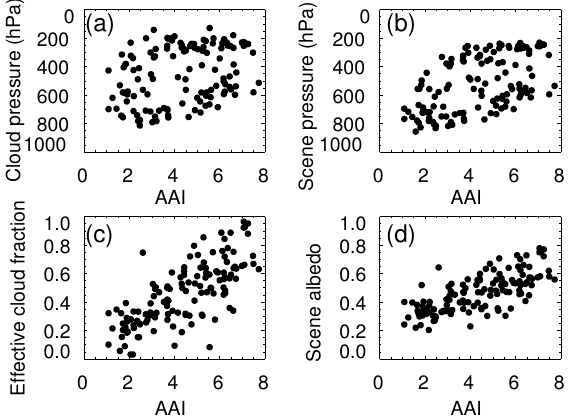
Fig. 12. Scatter plots of FRESCO (a) cloud pressure, (b) scene pres- sure, (c) effective cloud fraction, and (d) scene albedo versus ab- sorbing aerosol index (AAI) from GOME-2 measurements of the Puyehue volcanic ash plume on 6 June 2011 around 14:10UTC. The pixels used in the scatter plots are marked with the left box in Fig. 11 in the region of [35, 42] ◦ S and [65, 72] ◦ W.